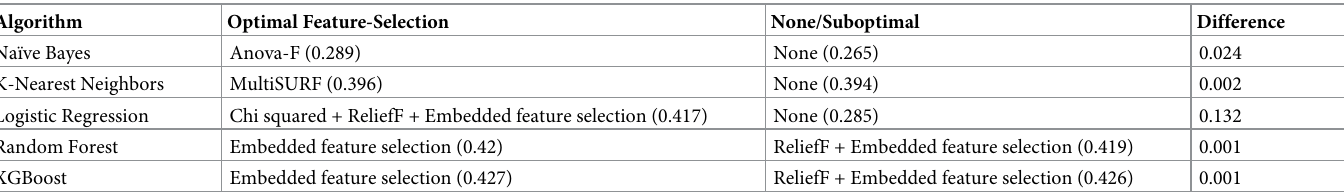
Table 4. Comparison of feature-selection routines.